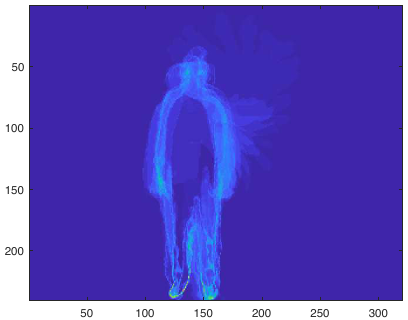
Figure 2. Stridden DMM generated for high wave action due to the proposed method.